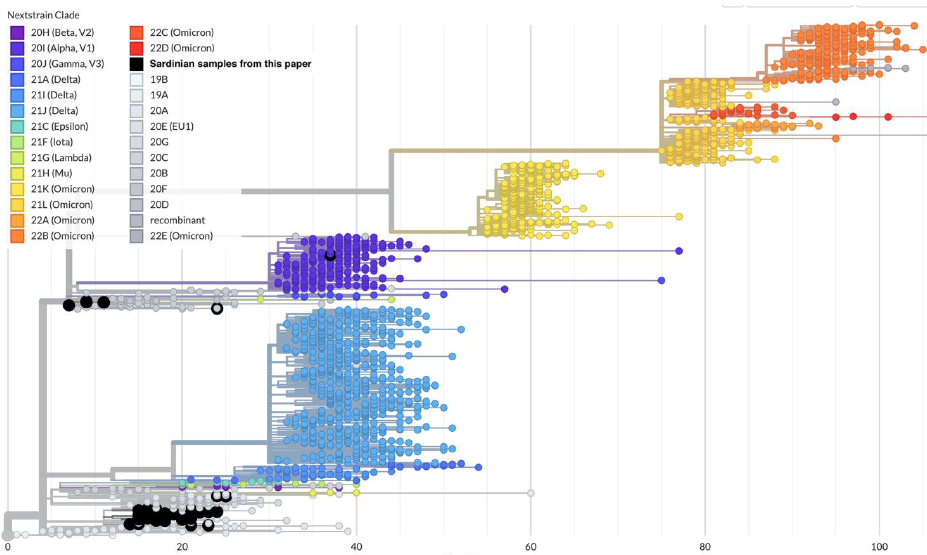
Figure 5. Assignment of the 55 Sardinian samples (large black circles) within the global SARS-CoV-2 phylogeny generated from Auspice/NextStrain. Most samples belong to the B.1.177 lineage and correspond to the NextStrain clade 20E (EU1).